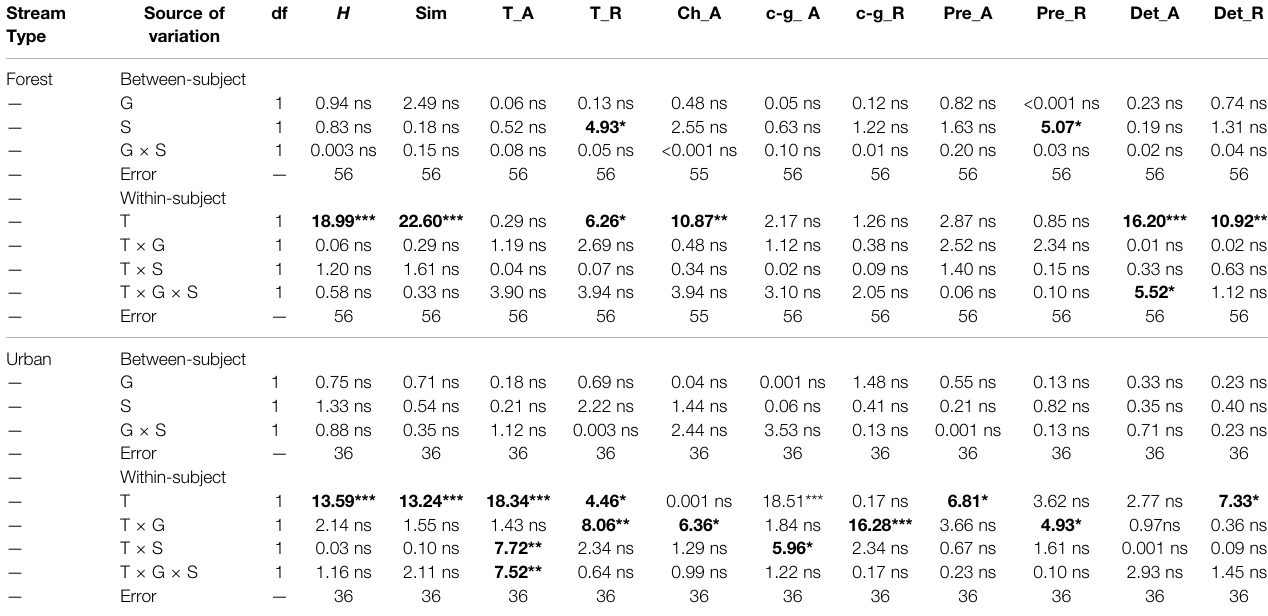
TABLE 2 | Results of general linear model comparing macroinvertebrate communities ( H , Shannon-Wiener diversity index; Sim, Simpson diversity index; total (T_A) and Chironomidae abundance (Ch_A); T_R, total richness; and abundance and richness of collector-gatherer (c-g), predator (pre), and detritivore) at fi rst (15 days) and second (30 days) sampling date across treatments of glyphosate (G) and carrion subsidy (S). Sampling date (T) was “ within-subject ” factor ( fi xed), glyphosate and carrion subsidy were “ between-subject ” factors ( fi xed). ns not signi fi cant, * p < 0.05, ** p < 0.01, *** p <